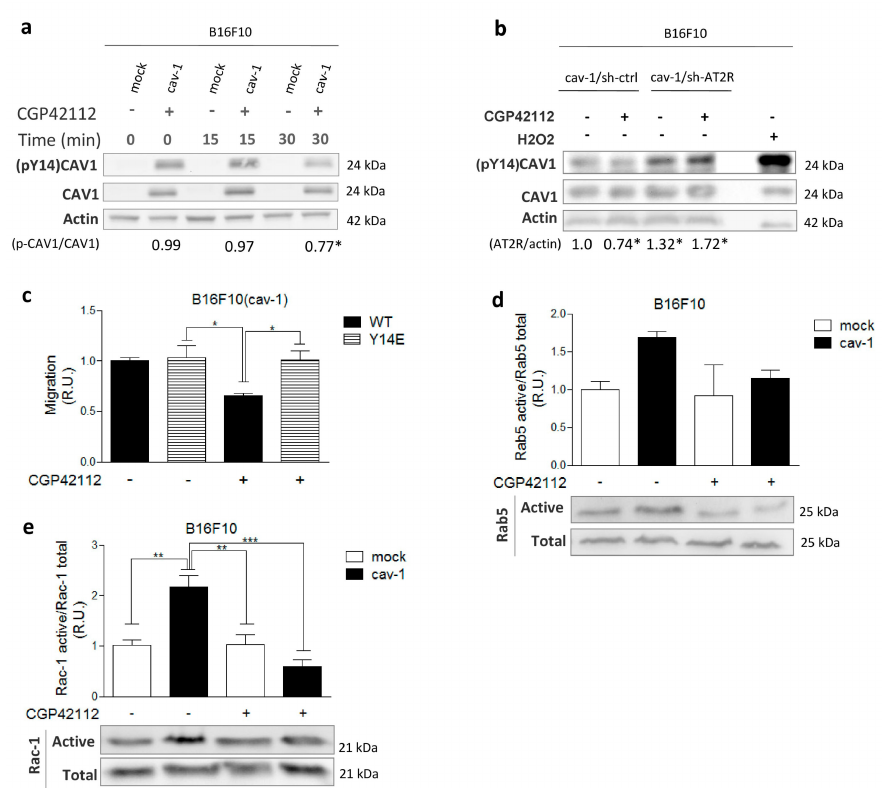
Figure 3. AngiotensinIItype-2receptor(AT2R)inducesdephosphorylationoftyrosine-14phosphorylated caveolin-1 (pY14(CAV1)) in B16F10(cav-1) cells and decreases Ras-related protein 5A (Rab5) and Ras-related C3 botulinum toxin substrate 1 (Rac1) activity. ( a ) Extracts from B16F10 cells pretreated for 0, 15, and 30 min with N- α − Nicotinoyl-Tyr-Lys-(N- α -Z-Arg)-His-Pro-Ile (CGP42112; 1 µ M) were analyzed by western blotting using antibodies against pY14-CAV1, CAV1, and β -actin. The numbers below individual lanes indicate the average pY14-CAV1 / CAV1 ratio normalized to the control condition (time 0) (N = 3). Time 0 (0.99 ± 0.09), 15 (0.97 ± 0.06), and 30 (0.77 ± 0.03) min. ( b ) B16F10(cav-1 / Y14E) were pretreated for 30 min with CGP42112 (1 µ M), and migration was evaluated as described. Values shown were normalized to those control B16F10(cav-1) cells without treatment (N = 3). ( c ) B16F10 cells were pretreated with CGP42112 (1 µ M) for 30 min before evaluating small G-protein activity in pull-down assays (PD). Samples from PD and cell lysates were immunoblotted with antibodies against Rab5 ( d ), Rac-1 ( e ), and β -actin. Graphs show either the active Rab5 / Total Rab5 ( d ) or active Rac-1 / total Rac-1 ( e ) ratio normalized to control conditions (mean ± standard error of mean, N = 3). Results obtained were compared statistically as explained in Materials and Methods. Significant differences compared with the untreated condition (basal) of control cells are indicated. *** p ≤ 0.001, ** p ≤ 0.01, * p ≤ 0.05. (R.U., relative